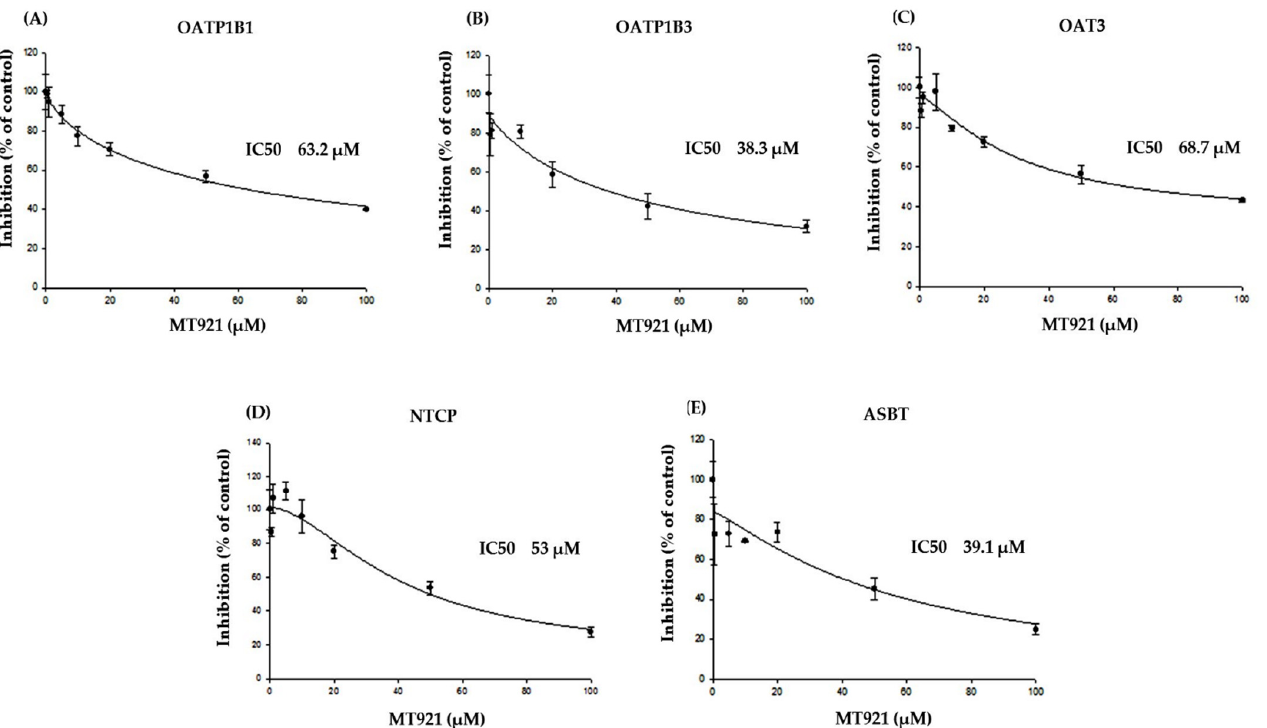
Figure 2. Concentration-dependent inhibition of MT921 uptake (0.5–100 µ M) on ( A ) 0.022 µ M [ 3 H]estrone-3-sulfate in HEK 293-OATP1B1; ( B ) 0.06 µ M [ 3 H]estradiol-17 β -D-glucuronide in HEK 293-OATP1B3; ( C ) 0.022 µ M [ 3 H]estrone-3-sulfate in HEK 293-OAT3; ( D ) 0.8 µ M [ 3 H]taurocholate in HEK 293-NTCP; ( E ) 0.8 µ M [ 3 H]taurocholate in HEK 293-ASBT. Each bar represents mean ± standard deviation from triplicate experiments. IC 50, drug concentration at 50% inhibition.